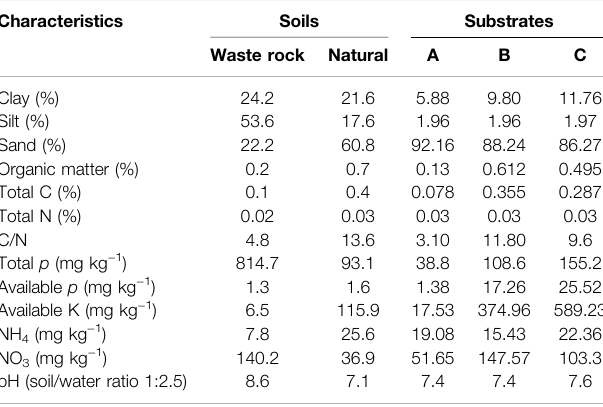
TABLE 1 | Physical and chemical characteristics of the waste rock (WR) soils compared to those of an undisturbed (Natural) site located outside the mining perimeter and the different cultivation